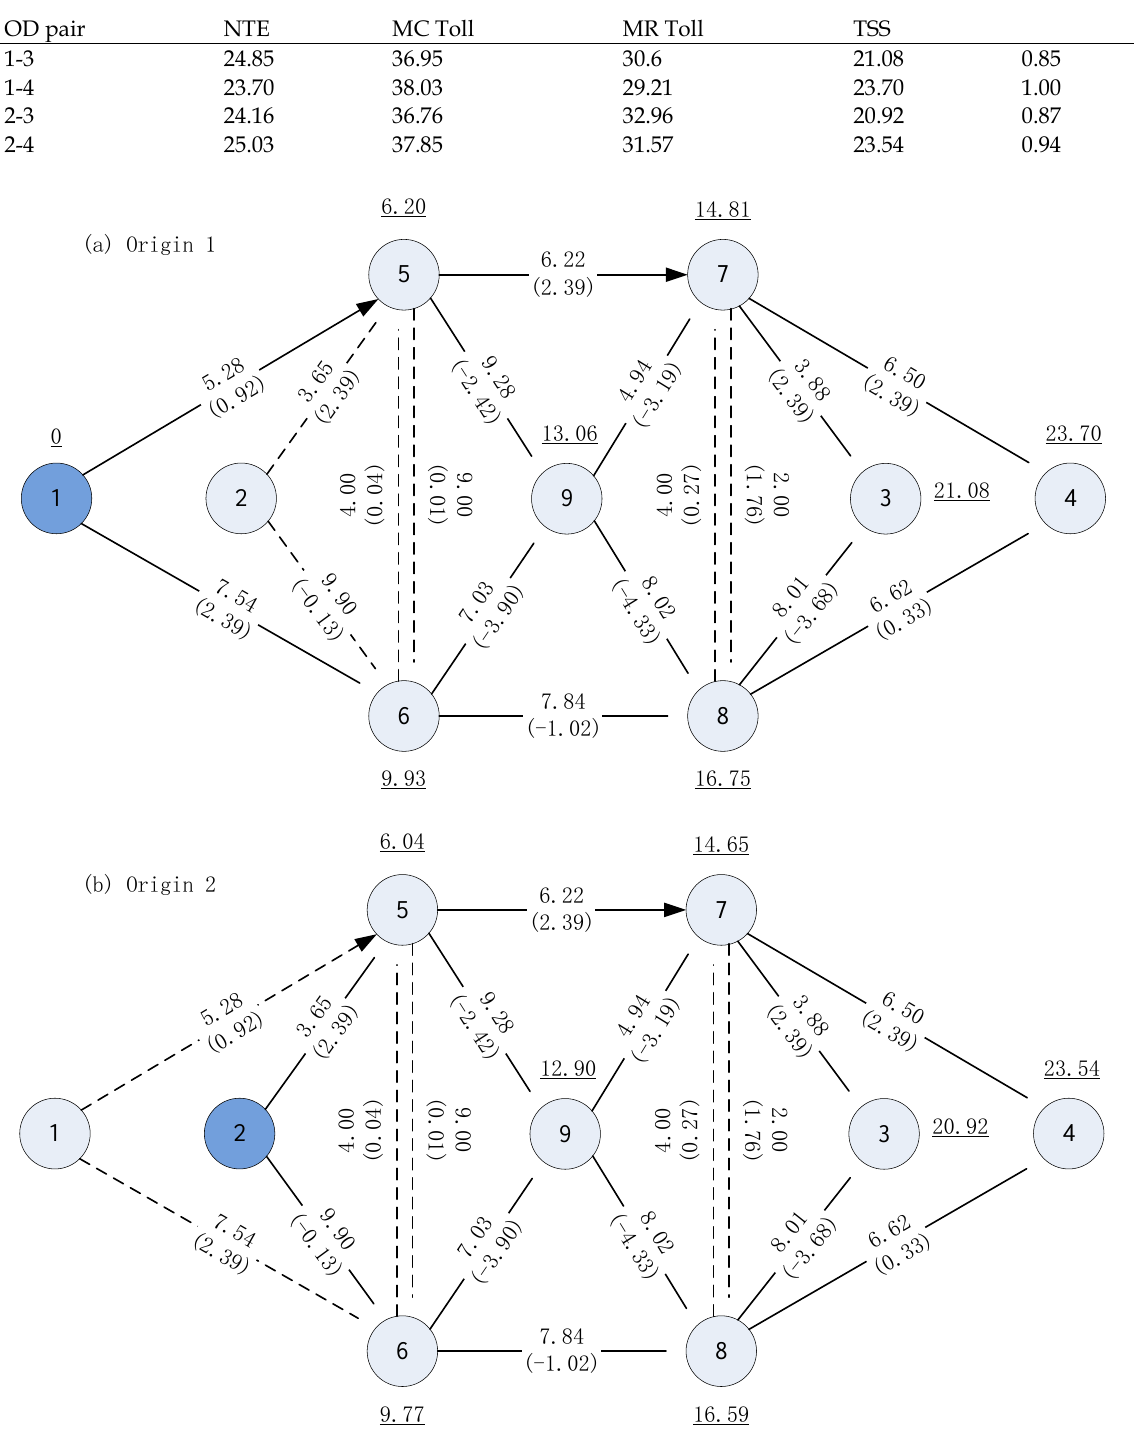
Table 2 Comparison of OD travel disutilities: NTE, MC Toll, MR Toll and TSS